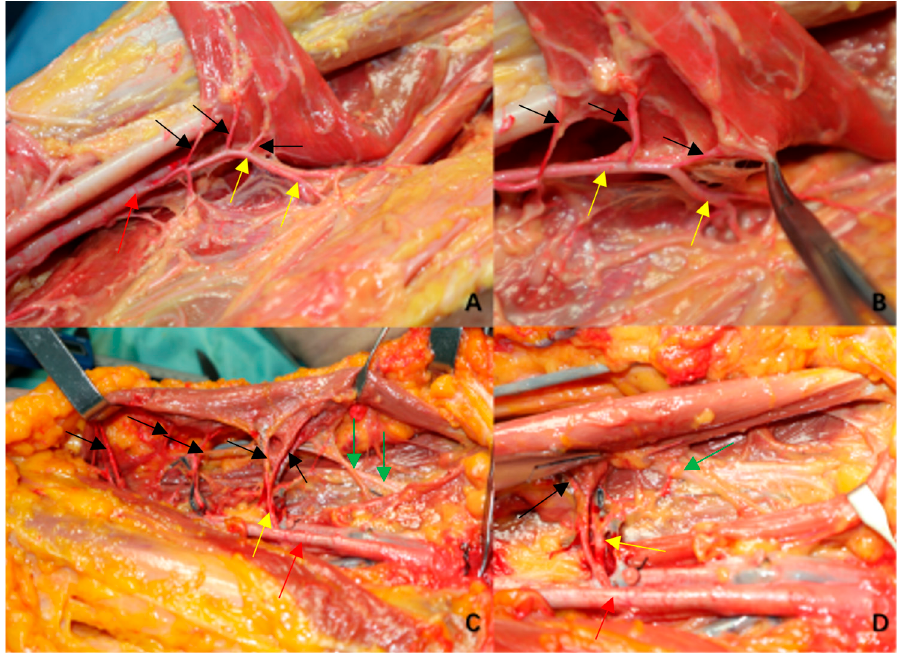
Figure 6. Pictures illustrating how the perforators and branch of ALF go into the muscle ( A , B ) are from the No.5 cadaver after the adductor longus lifted from the insertion of the pubic body. ( A ) shows the perforators of adductor longus come from the perforating artery of femoral profound artery. ( B ) expands the perforators of adductor longus in ( A ). ( C , D ) are from No.2 cadaver. It is obvious that muscular perforators and dominant nerves of adductor longus flap are beneath the muscle. (Red arrow: femoral profound artery. Yellow arrow: the perforating artery of femoral profound artery. Black arrow: the perforators of adductor longus. Green arrow: the dominant nerves of the adductor longus.).